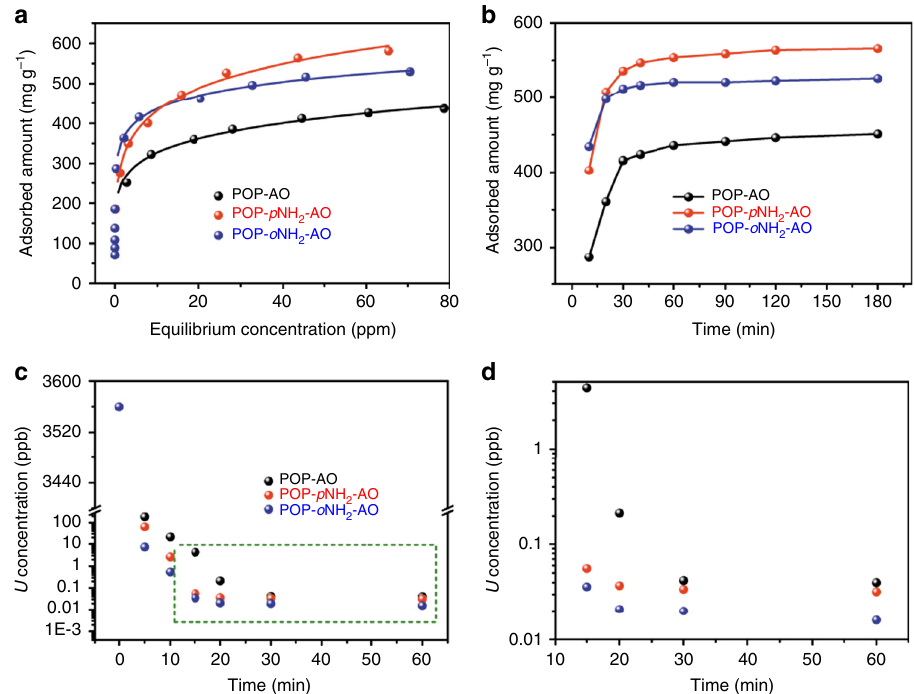
Fig. 2 Uranium adsorption isotherms and kinetics investigations. a Uranium sorption isotherms for POP-based adsorbents. The lines are fi t with the Langmuir model; all the fi ts have R 2 values higher than 0.99. b The kinetics of uranium adsorption from aqueous solution with an initial concentration (7.56 ppm, 400 mL), at pH ~6, and adsorbent material (3 mg). c Uranium removal kinetics with an initial concentration of 3560 ppb (pH ~6) at a V / m ratio of 50,000mL g − 1 . d Enlarged section of green rectangle in